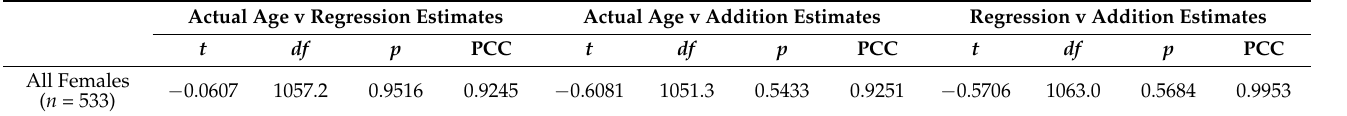
Table 4. T-test and Pearson coefficient analyses comparing estimates derived by regression versus simple addition (females only, n = 533).